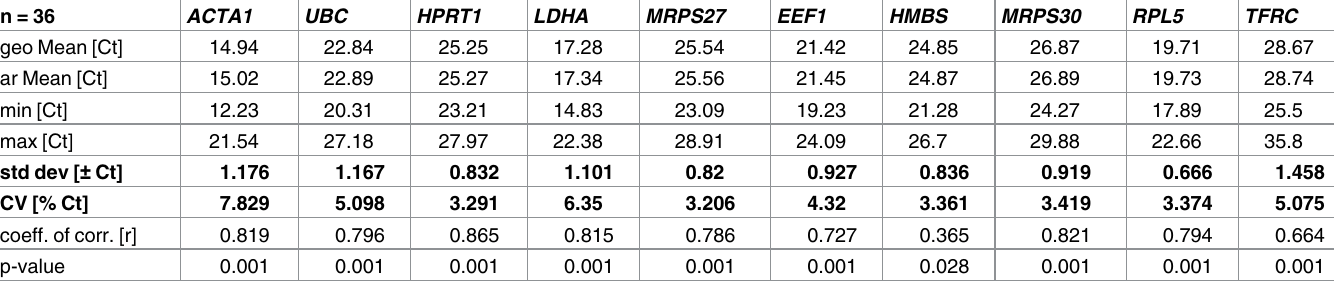
Abbreviations: Ct: Cycle threshold; geo Mean [Ct]: Geometric mean of Ct; ar Mean [Ct]: Arithmetic mean of Ct; Min [Ct] and Max [Ct]: Cycle threshold values; std dev [ ± Ct] [ ± Ct]: Standard deviation (SD) of Ct; CV [% Ct] : Coefficient of variation of Ct levels in percentage; coeff. of corr. [r]: Coefficient of correlation; SD and CV are indicated in bold.